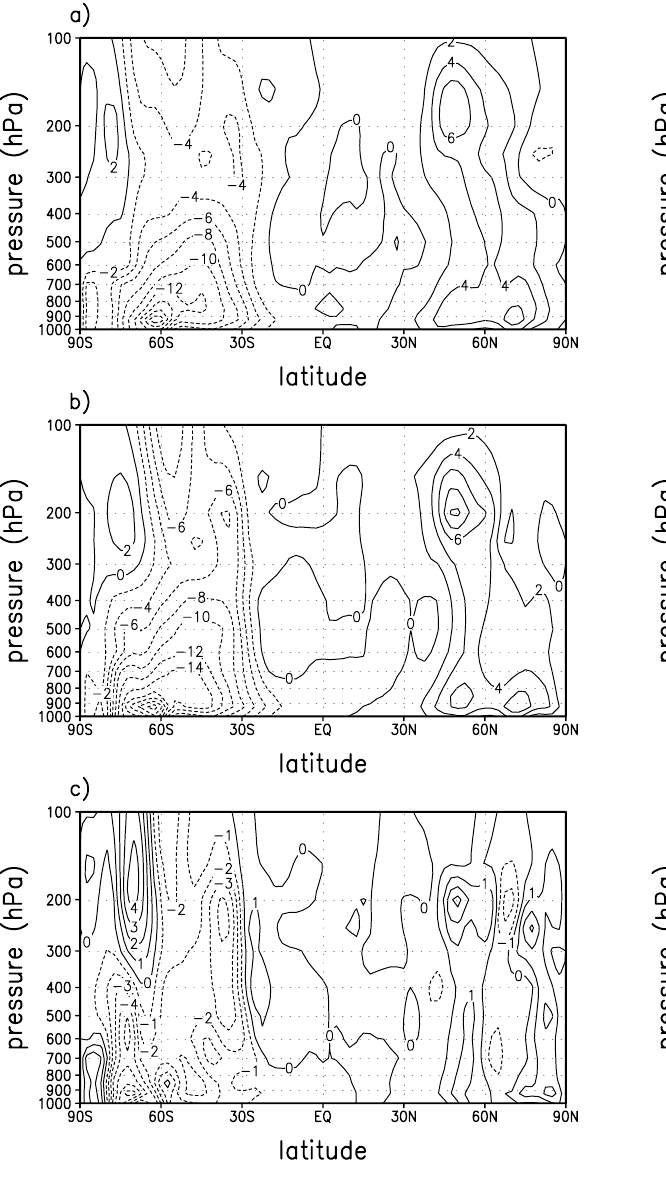
Fig. 9. Zonally-averaged eddy momentum flux for July: (a) 1995, (b) 1997, and (c) Difference (1997 minus 1995). Units, m 2 s − 2